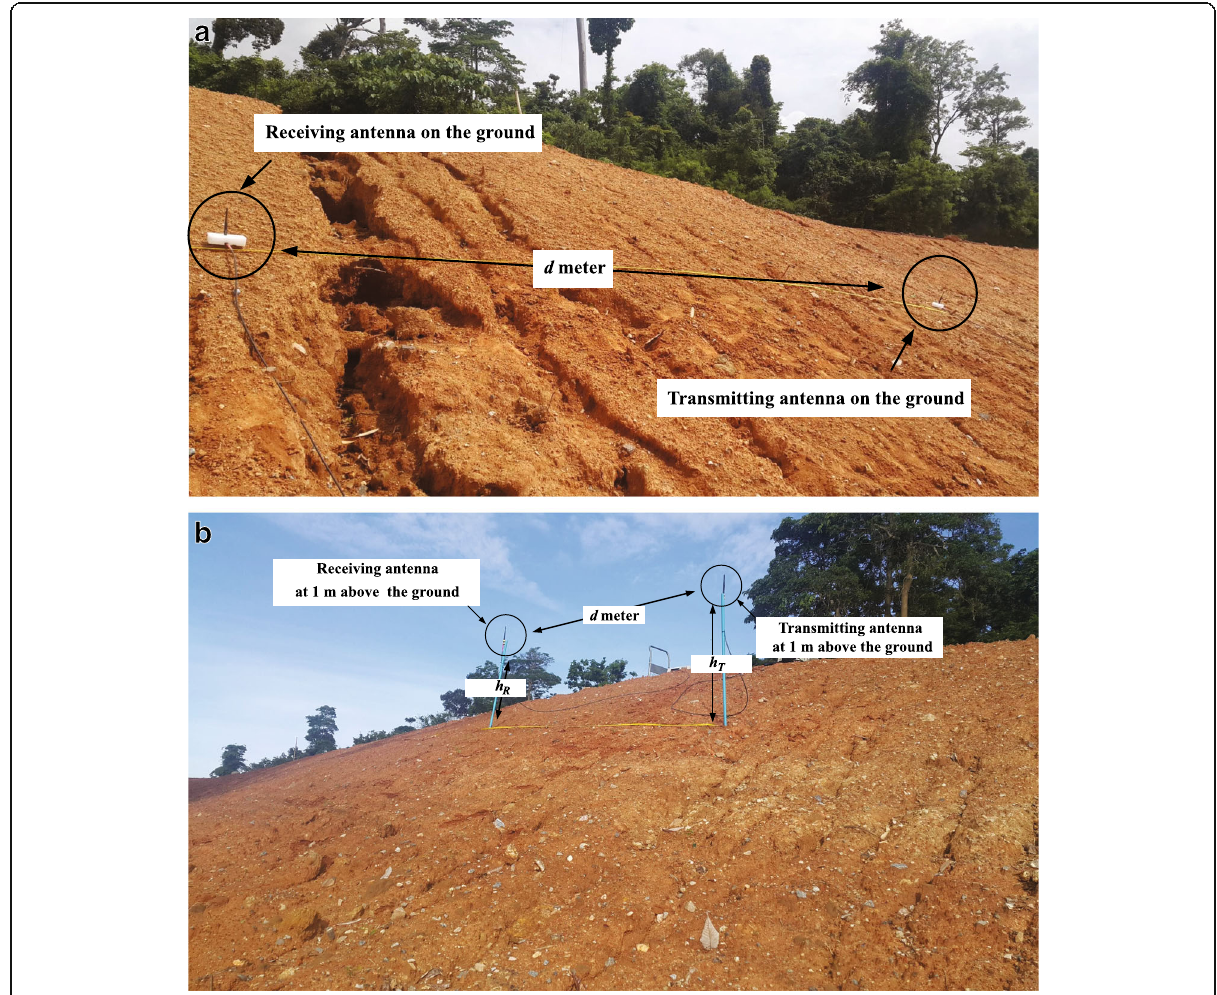
Fig. 2 Measurement setup. a First case. b Second